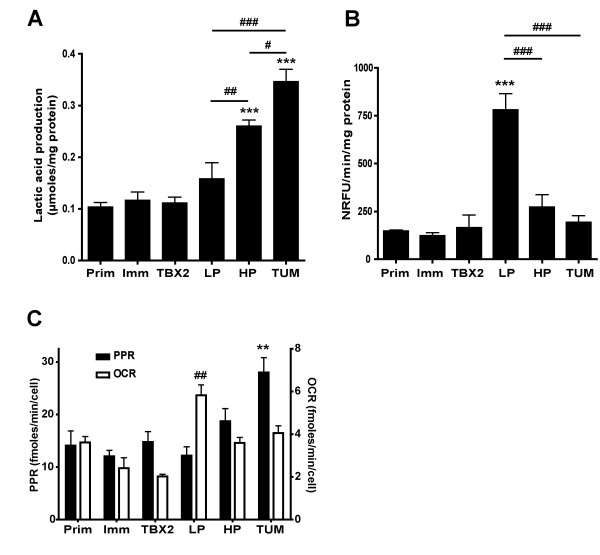
Lactic acid production, oxygen consumption and proton production rate. A: Lactic acid production in μ moles/mg protein (mean ± SEM). Lactic acid production was measured in media samples taken from the cell cultures used to obtain the cell doubling time data in Table 1. Six independent experiments, each in duplicate, were conducted for all cell populations, except Ras-HP (n = 8) and Ras-TUM (n = 7). Lactic acid production increases with passage number in H-RasV12/E1A-transformed cells. ***:p < 0.001 compared to Prim-MEF. #:p < 0.05; ##:p < 0.01; ###:p < 0.001 for Ras-LP – Ras-HP – Ras-TUM intercomparisons (one-way ANOVA/Bonferroni). B: Oxygen consumption in NRFU/min/mg protein measured in BD oxygen biosensor plates (mean ± SEM). Each experimental value represents n = 3 (Prim-MEF, Imm-MEF, TBX2-MEF) or n = 6 (other cell populations) independent assays, each carried out in triplicate. Cells were seeded at 200,000 cells per well of a 384-well plate. Oxygen consumption peaks immediately after H-RasV12/E1A transformation, and then decreases with passage number. ***:p < 0.001 compared to Prim-MEF. ###:p < 0.001 for Ras-LP – Ras-HP – Ras-TUM intercomparisons (one-way ANOVA/Bonferroni). C: Proton production rate (PPR) and oxygen consumption rate (OCR) per cell measured in Seahorse XF24 analysis 48 hours post seeding (mean ± SEM; n = 6, except Ras-HP, n = 4). Prim-MEF, Imm-MEF and TBX2-MEF cells were seeded at 25,000/well. Ras-LP, Ras-HP, Ras-TUM cells were seeded at 30,000/well. PPR: **:p < 0.01 compared to Prim-MEF. OCR: ##:p < 0.01 compared to Prim-MEF (one-way ANOVA/Bonferroni). These data confirm the gradual increase in cellular acidification and decrease in oxygen consumption described in (A) and (B) in real time analysis.